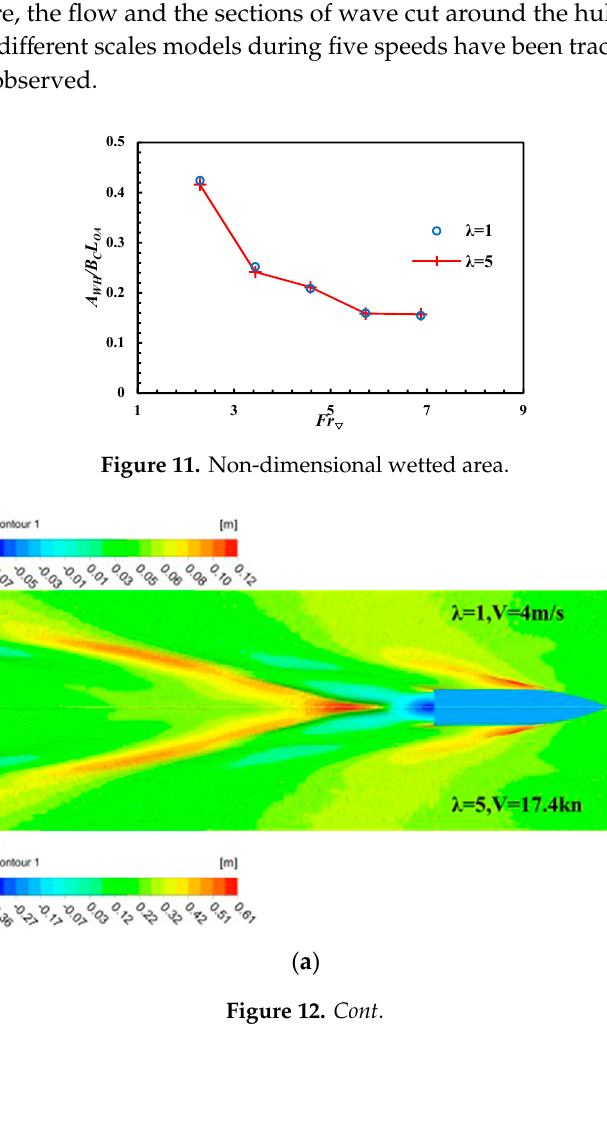
Figure 10. Bottom view of wave characteristics of stepped planing hull in both model and full-scaled boat: ( a ) 𝐹𝑟 ∇ = 2.29 ; ( b ) 𝐹𝑟 ∇ = 3.34 ; ( c ) 𝐹𝑟 ∇ = 4. .58 ; ( d ) 𝐹𝑟 ∇ = 5.73 ; ( e ) 𝐹𝑟 ∇ = 6.87 .